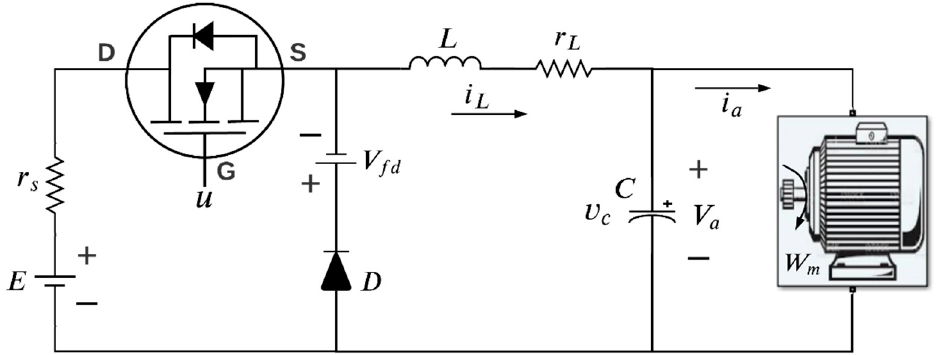
Figure 2. Model of the buck-motor system.